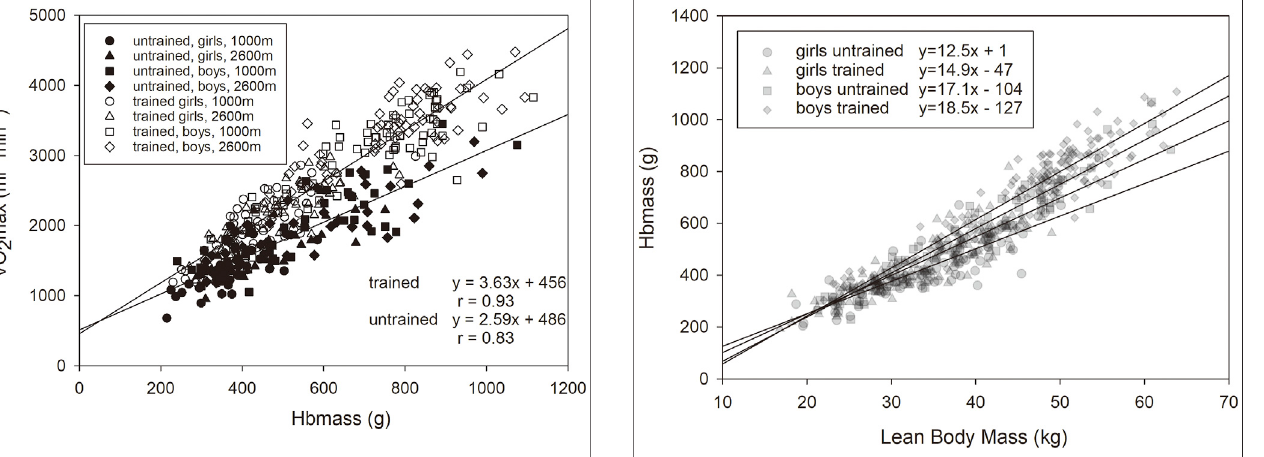
FIGURE4| Relationshipbetweenleanbodymass(LBM)andHbmassin the trained and untrained male and female